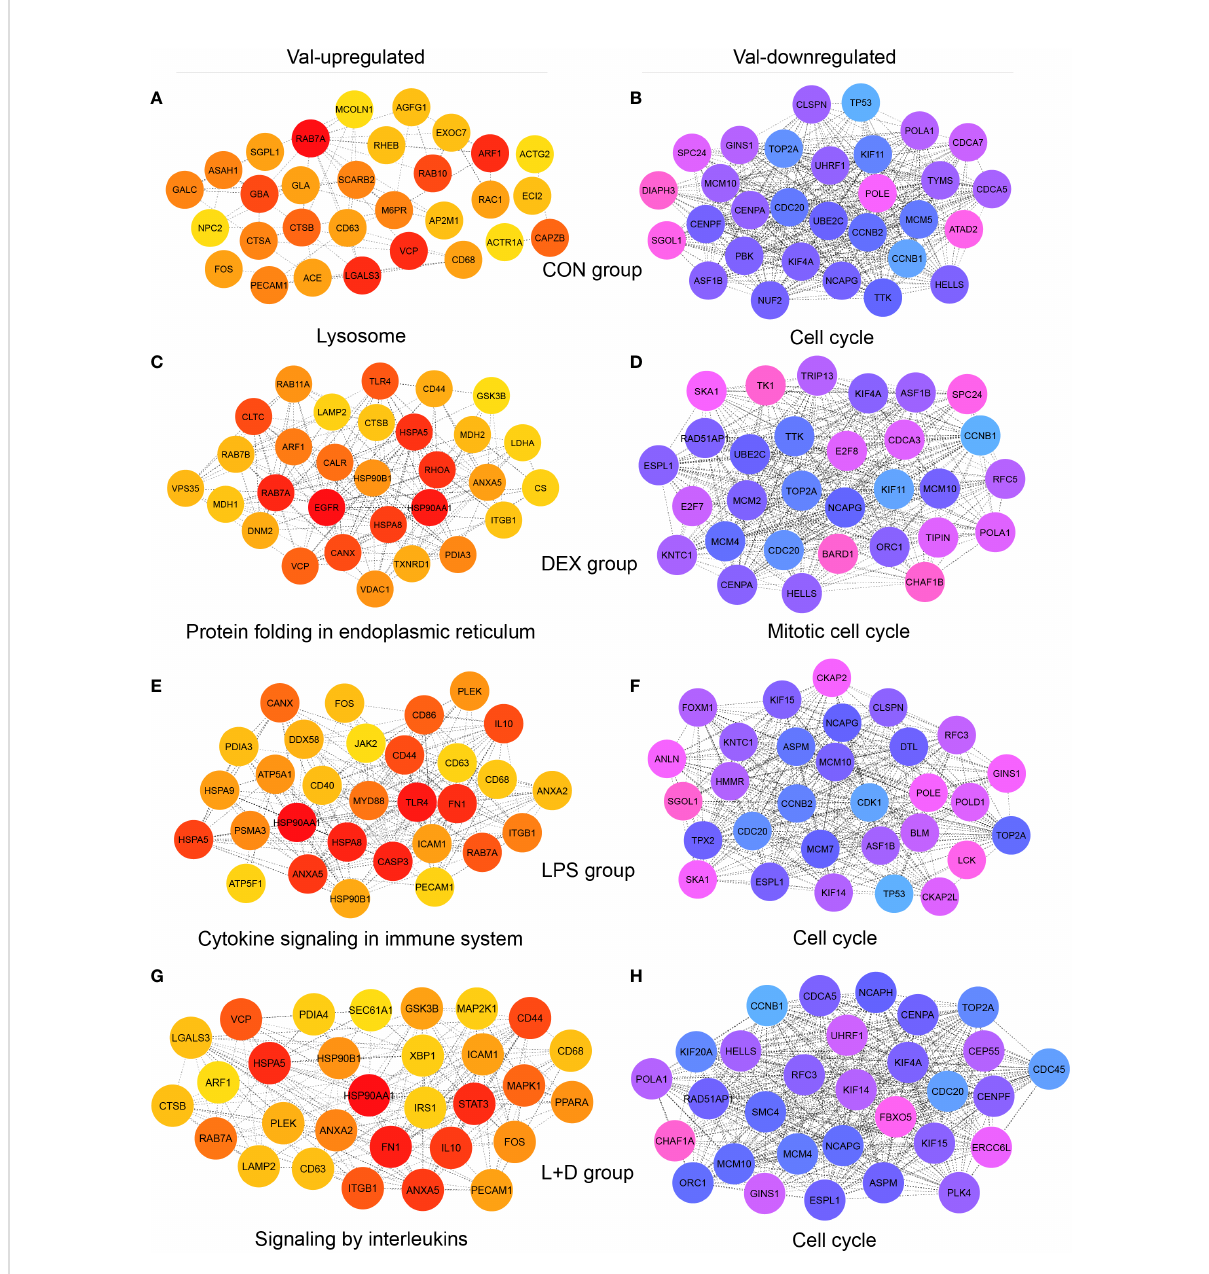
FIGURE 6 Identi fi cation of hub genes of Val-up and Val-down clusters in each treatment group. (A-H) Protein-protein interaction (PPI) networks showing top 30 hub genes with high connectivity within (A) Val-up cluster in CON group, (B) Val-down cluster in CON group, (C) Val-up cluster in DEX group, (D) Val-down cluster in DEX group, (E) Val-up cluster in LPS group, (F) Val-down cluster in LPS group, (G) Val-up cluster in LPS+DEX group, and (H) Val-down cluster in LPS+DEX group. PPI networks were constructed by the STRING database (27) and top 30 hub genes of each network were identi fi ed by the Cytoscape plugin cytoHubba (28, 29). Connectivity was correlated with color of circles where red and blue indicate higher degree whereas yellow and pink indicate lower degree. The most signi fi cant functional terms of hub genes of each cluster were identi fi ed using the Metascape (30) and